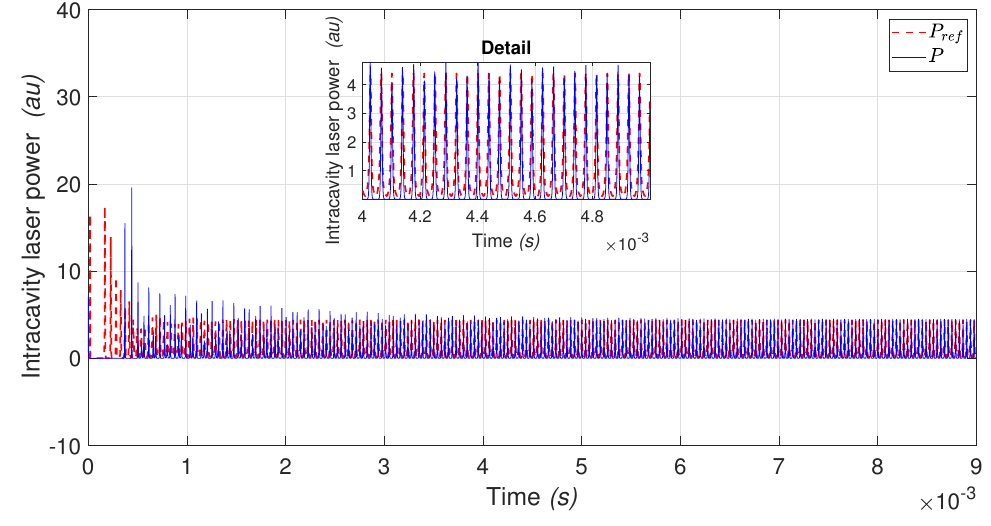
Figure 9. EDFL tracking to P 3. Figure 10 illustrates the EDFL behavior toward the period-4 P 4 orbit. P ref is repre- sented by the red dashed line, and P of EDFL by the blue continuous line. This figure shows the tracking trajectory of the EDFL ( P ) to the reference ( P ref ), where the reference is P 4 generated by the exogenous system. The inset illustrates a rapid convergence. The chosen gain parameters are k 1 = − 2.1 × 10 12 , λ 1 = 0.001, and α 1 = 0.6.